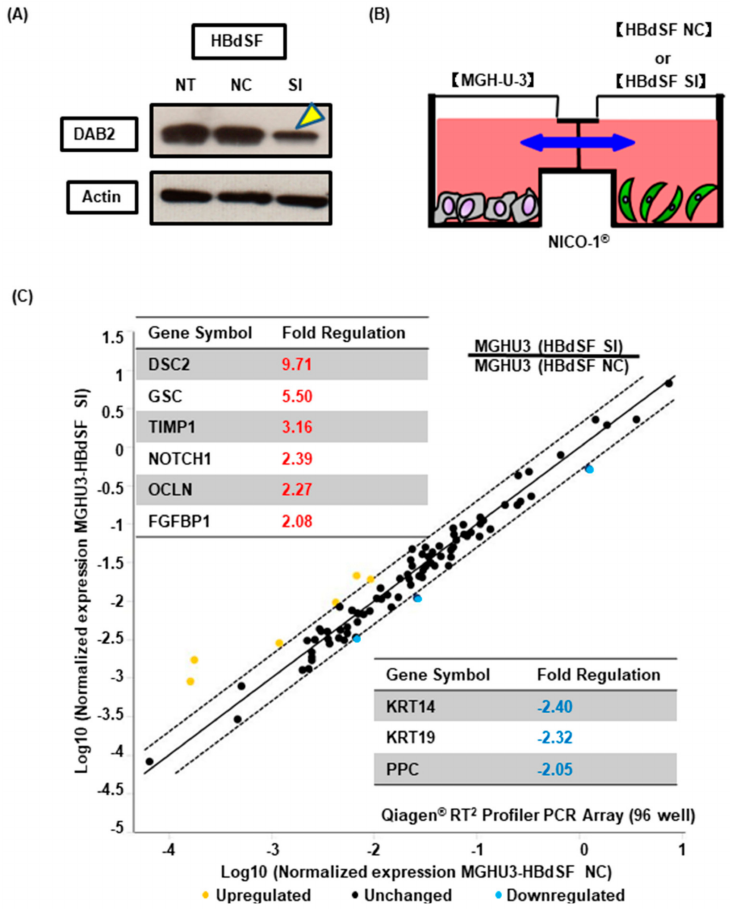
Figure 5. ( A ) HBdSF cells knocked-down by DAB2 siRNA transfection, DAB2 protein reduction was confirmed by WB. Yellow arrowhead indicates DAB2 protein bands reduced by siRNA. ( B ) Indirect co-culture dish (Nico-1 ® ) cannot pass cells, whereas only fluid factors can pass through the filter freely. We placed MGH-U-3 cells in one plate and HBdSF negative control or si RNA cells in another plate. ( C ) Changes in epithelial-to-mesenchymal transition (EMT) markers in MGH-U-3 cells were evaluated by PCR assays for EMT markers. NT: No treatment; NC: Negative control; SI: DAB2 -si